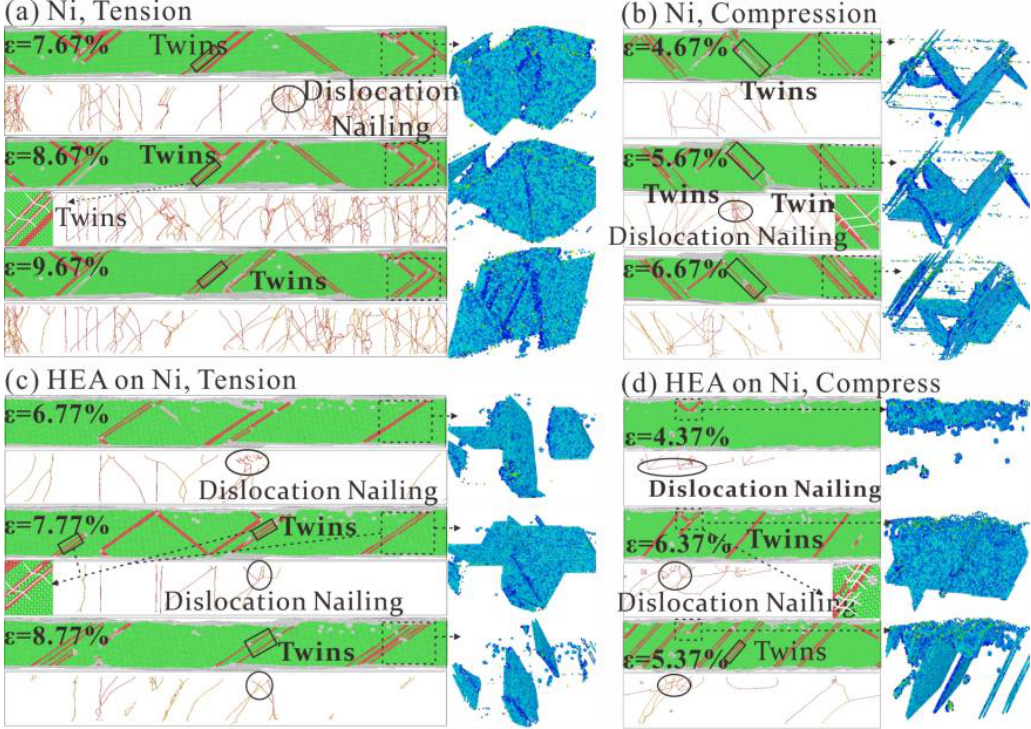
Figure 12. Dislocation analysis diagram obtained by tensile-compression of pure Ni and Ni reinforced with the Fe 33 Ni 32 Cr 11 Co 11 Cu 13 HEAs coating at 300 K. ( a ) CSP, DXA and CAN at tensile (pure Ni) strain of 7.67%, 8.67% and 9.67%, respectively. ( b ) CSP, DXA and CAN at compressive (pure Ni) strain of 4.67%, 5.67% and 6.67%, respectively. ( c ) CSP, DXA and CAN at tensile (Ni with the HEAs coating) strain of 6.77%, 7.77% and 8.77%, respectively. ( d ) CSP, DXA and CAN at compressive (pure Ni) strain of 4.37%, 5.37% and 6.37%,